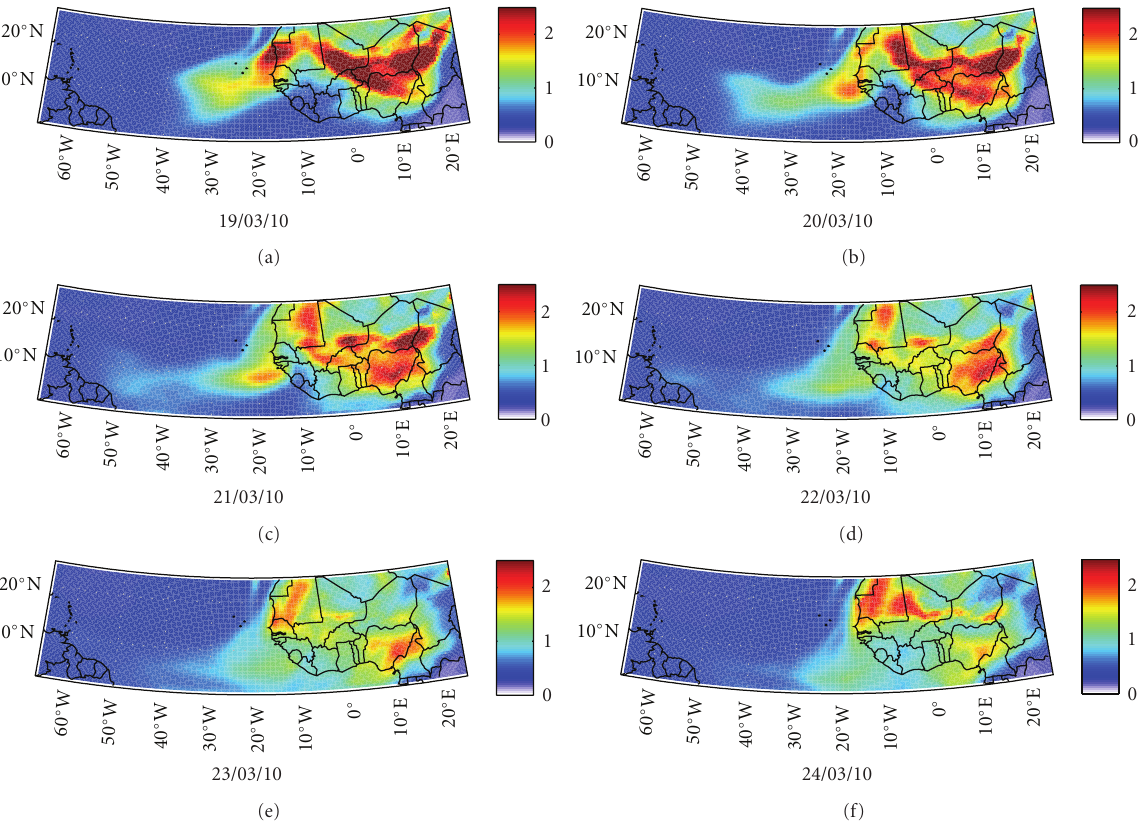
Figure 5: Evolution of dust particles (episode of March 17–21st, simulated with the RegCM 4.0) from the African continent towards the Atlantic Ocean between March 19–24th 2010.